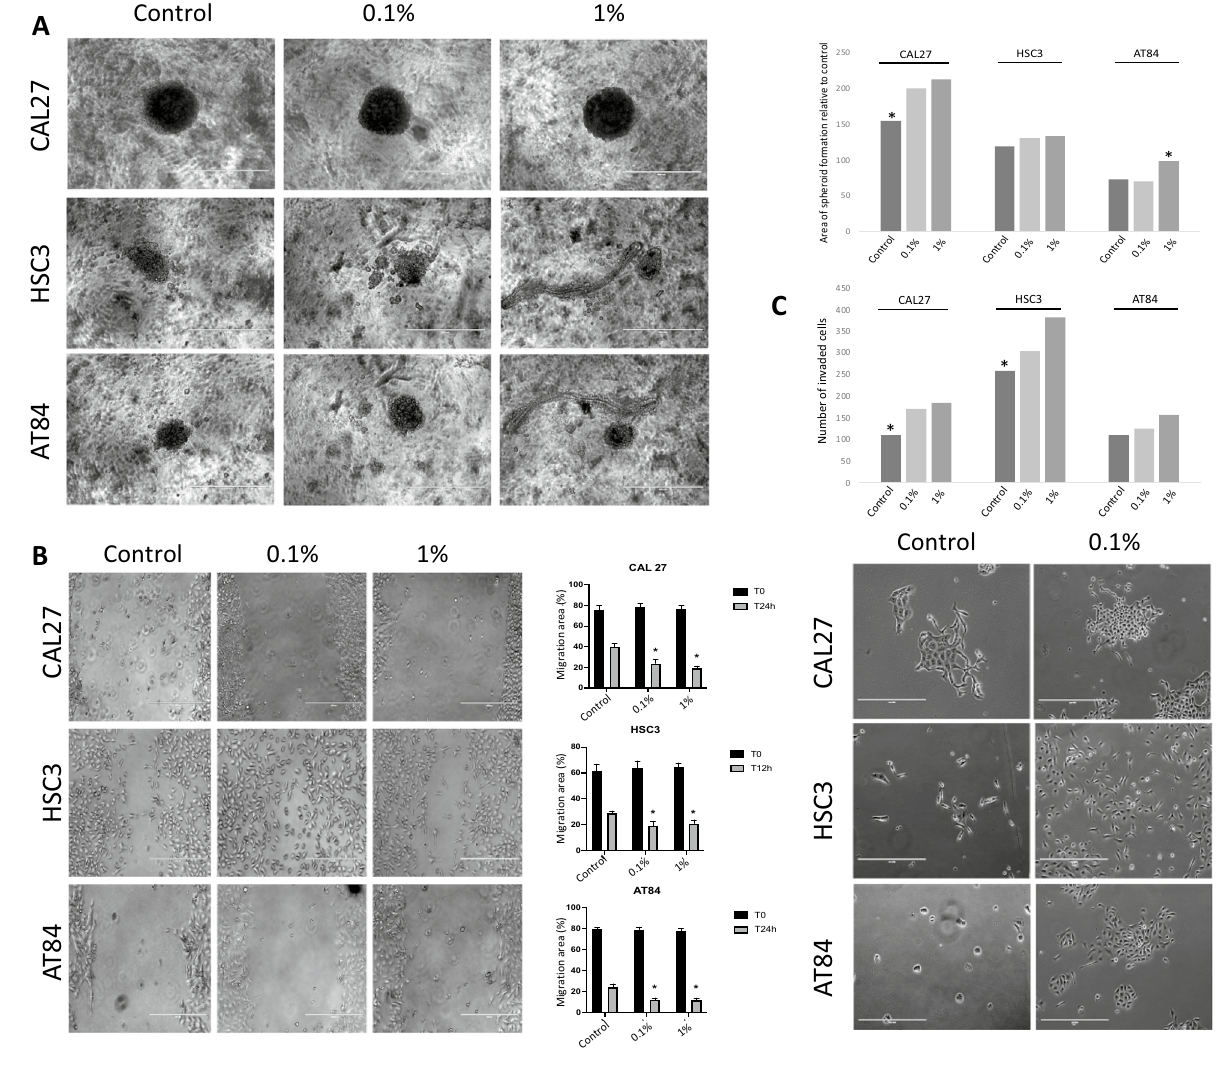
Figure 3. E-liquid increases anchorage-independent cell growth and promotes tumor migration and invasion in OSCC cells. ( A ) E-liquid treatment increased the number and size of spheroid formation in semisolid media. CAL27, HSC3 and AT84 cell lines were able to survive after E-liquid treatment and exhibited anchorage- independent growth ( B ) Wound healing assays show that e-liquid stimulation with 0.1% or 1% nicotine can promote migration and invasion of OSCC quiescent cells. Cells treated with media containing 10% FBS were used as the positive control for the assay. E-liquid induced the migration and invasion of the cells in a dose- dependent manner. ( C ) E-liquid was able to potently promote invasion of OSCC cells at a concentration of 0.1% and 1% as seen in a Boyden-chamber assay. E-liquid induced the migration and invasion of the cells in a dose- dependent manner. * P <